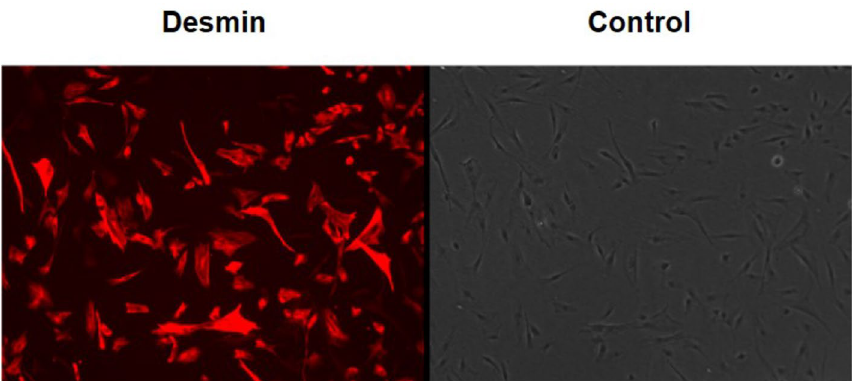
Figure 7. Representative images for immunofluorescent staining for desmin of human muscle cell cultures. Myoblasts are desmin positive (red) and non-myoblasts are desmin negative. Myoblast to fibroblast ratio is 2.9. Magnification is ×